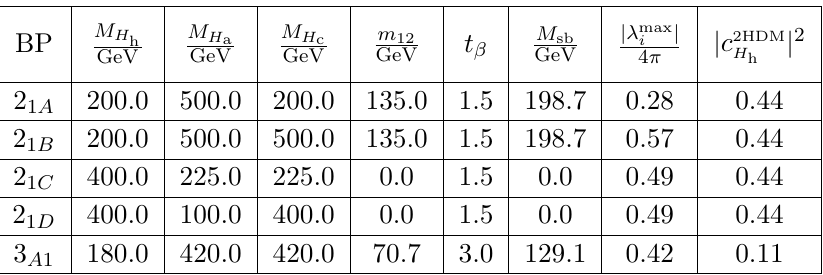
Table 1 . 2HDM benchmark points (BP) in the alignment limit, i.e. c (cid:11)(cid:12) = 0, taken from ref. [22]. In the alignment limit, c 2HDM H l j j